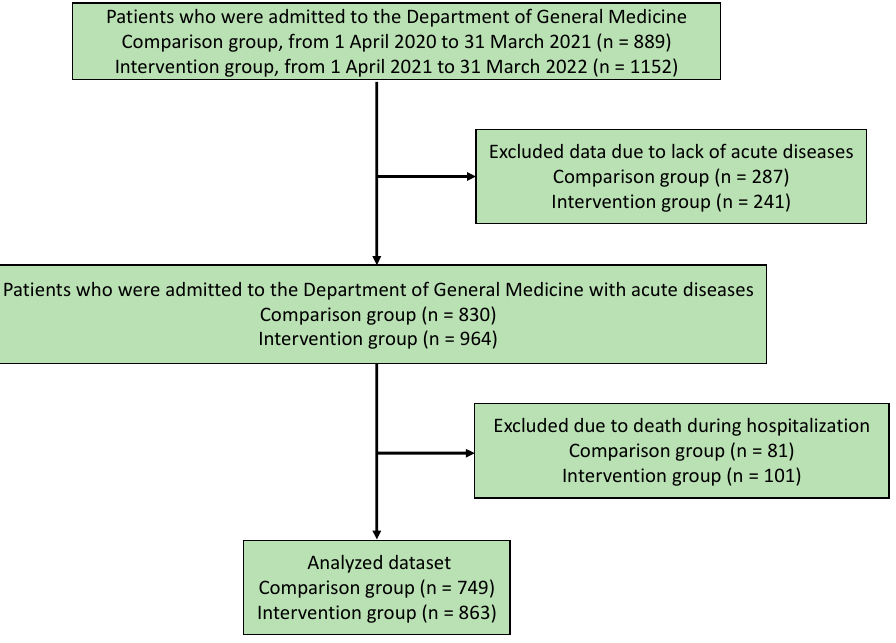
Figure 2. Flowchart of the participant selection.